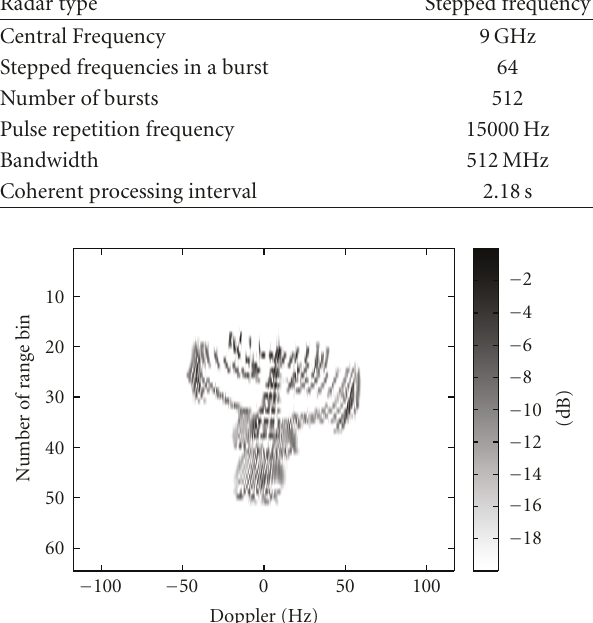
Figure 4: ISAR image after applying RDA to the simulated data for the entire CPI.